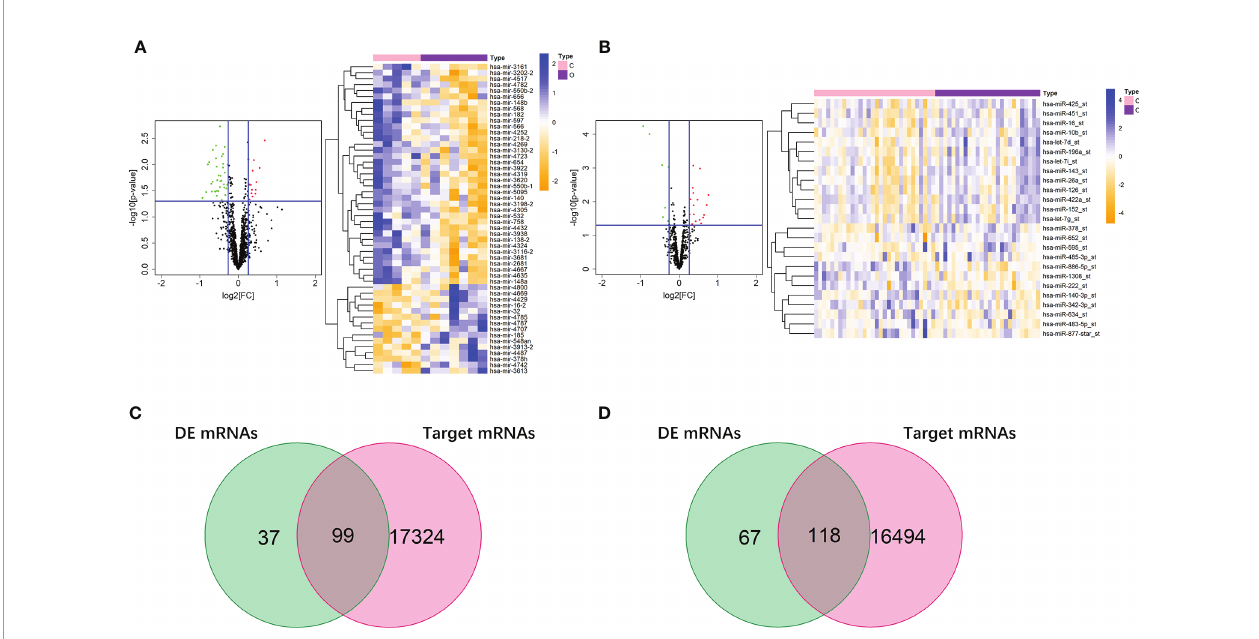
FIGURE 4 | DE miRNAs of obesity in VAT and SAT. 52 DE miRNAs of obesity were screened out in VAT (A) , and 25 were screened out in SAT (B) . The red points in the volcano plots represent upregulation and the green plots represent downregulation. The color in heatmaps from blue to yellow shows the progression from low expression to high expression. Venn diagrams (C, D) shows that the intersections of DE mRNAs of obesity and predicted target mRNAs in miRNA-mRNA pairs were 99 and 118 for VAT (C) and SAT (D) ,